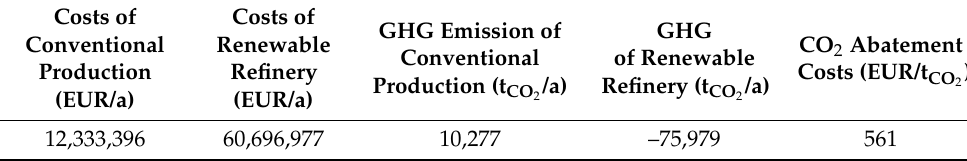
Table 11. Calculated CO 2 abatement costs of renewable refinery base case.